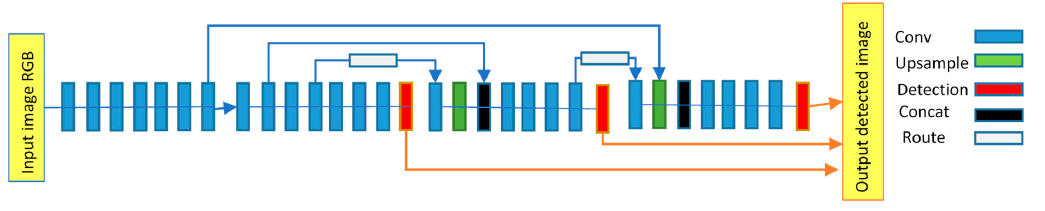
Figure 2. Block diagram of MangoYOLO model.